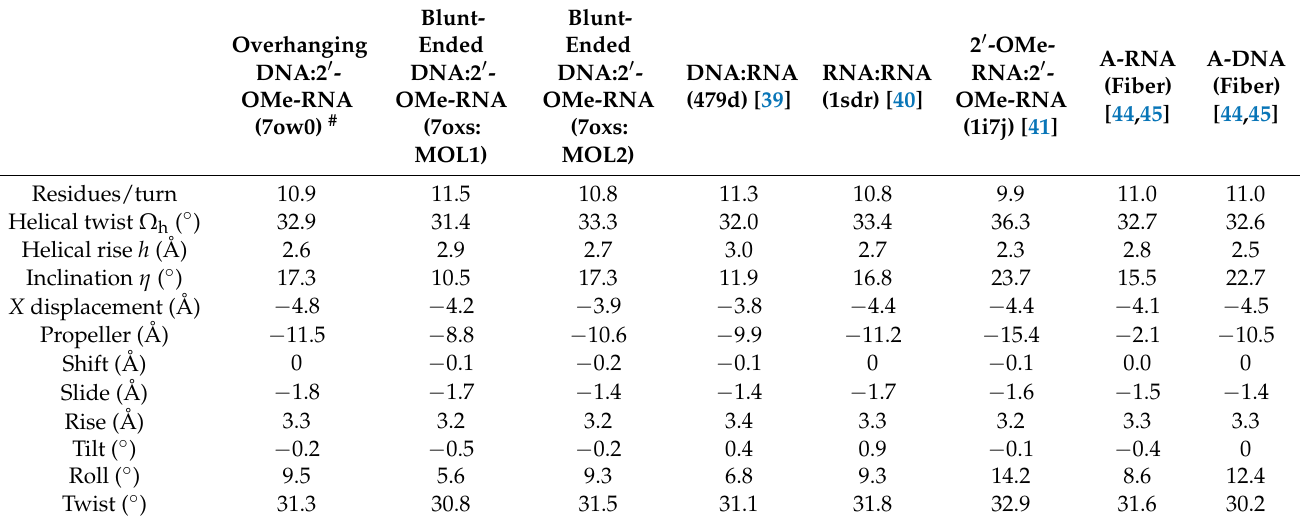
Table 3. Average base-pair and local base-pair helical